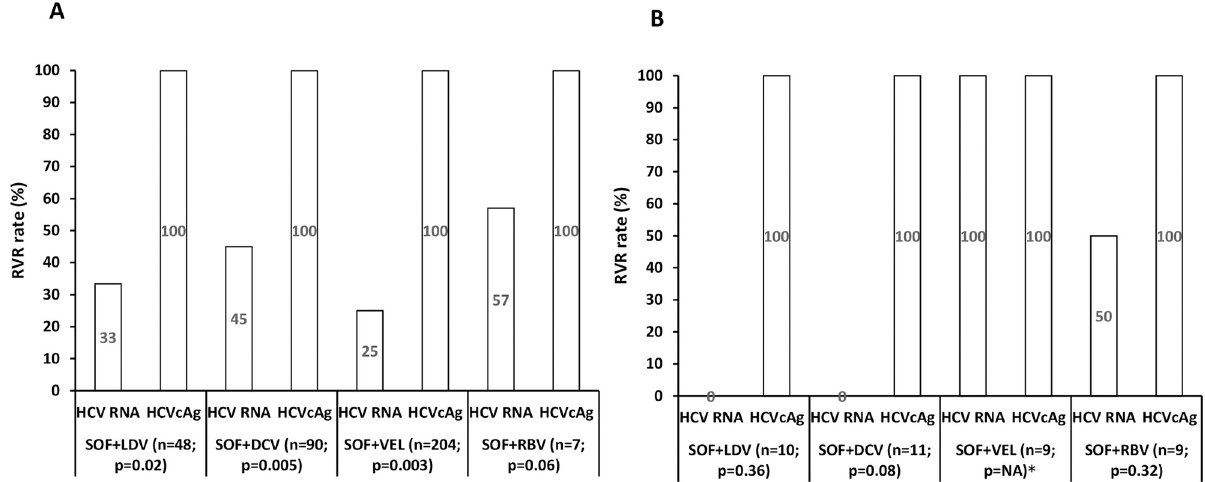
Fig 5. RVR rate in various DAA regimens (A) Treatment-na ï ve. (B) Previously treated. Abbreviations: HCV, hepatitis C virus; RNA, ribonucleic acid; HCVcAg, hepatitis C virus core antigen; RVR, rapid virological response; SOF, sofosbuvir; LDV, ledipasvir; DCV, daclatasvir; VEL, velpatasvir; RBV, ribavirin; � NA: not applicable.